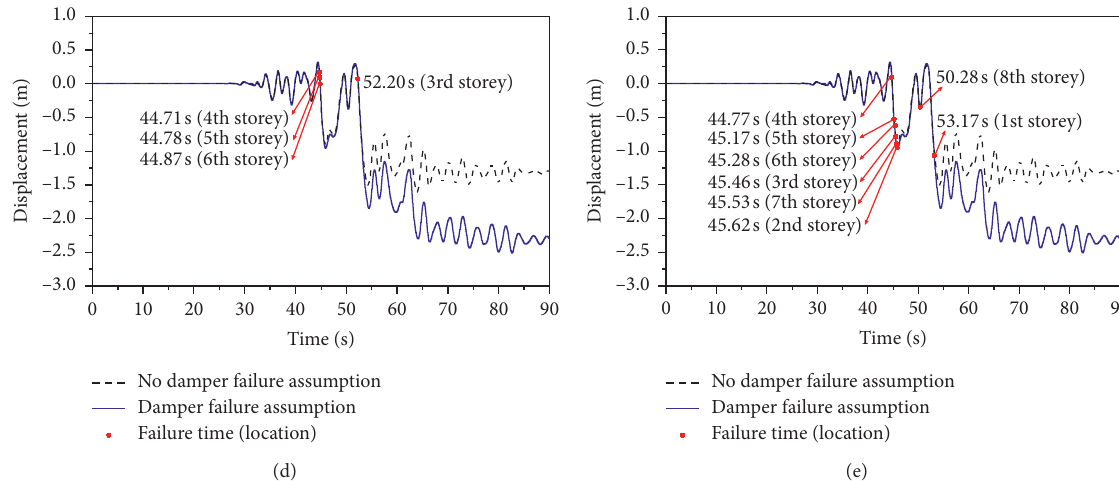
Figure 13: Displacement responses of the top storey of building-damper systems. (a) Building-BRB system. (b) Building-FD system. (c) Building-SCD system. (d) Building-VD system. (e) Building-VED system.